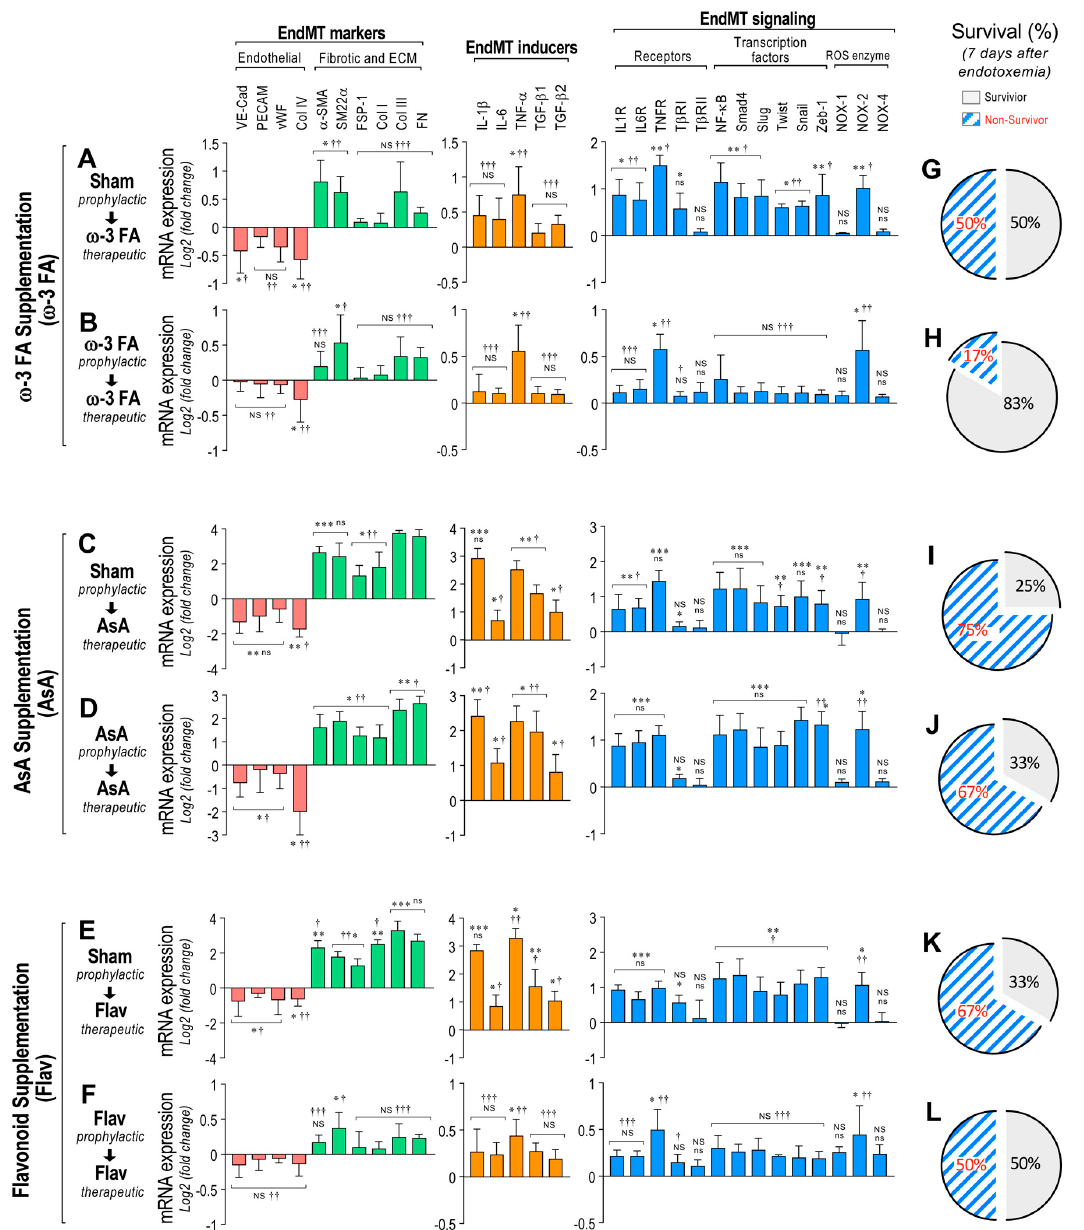
Figure 2. Impact on EndMT gene expression through dietary supplementation based on ω –3 FA, ascorbic acid, or polyphenolic antioxidant flavonoids in endotoxemic rats. ( A – D ) The mRNA expres- sion of EndMT markers (endothelial markers (red bars) and fibrotic and ECM markers (green bars)), EndMT inducers (orange bars) and EndMT signaling (blue bars) were detected in rats subjected to endotoxemia and supplemented with ω –3 fatty acid ( ω -3 FA, ( A , B )), ascorbic acid (AsA, ( C , D )), or polyphenolic antioxidant flavonoids (Flav, ( E , F )) through a therapeutic ( A , C , E ) and a prophylactic ( B , D , F ) protocol. ( G – L ) Survival percentage was determined 7 days after endotoxemia induction in rats subjected to endotoxemia and supplemented with ω –3 fatty acid ( ω –3 F ( G , H )), ascorbic acid (AsA, ( I , J )), or polyphenolic antioxidant flavonoids (Flav, ( K , L )) through a therapeutic ( G , I , K ) and a prophylactic ( H , J , L ) protocol. Statistical differences were assessed by a one-way analysis of variance (ANOVA) (Kruskal–Wallis) followed by Dunn’s post hoc test. * p < 0.05, ** p < 0.01, *** p < 0.001 compared with the saline-treated condition. † p < 0.05, †† p < 0.01, ††† p < 0.001 compared with the mRNA-expression values from endotoxemia-treated rats shown in Figure 1B. NS: non-significant. Determination of mRNA expression was normalized relative to 28S mRNA and are expressed relative to sham-supplemented condition. Values are expressed as the mean ± SD. ( N =